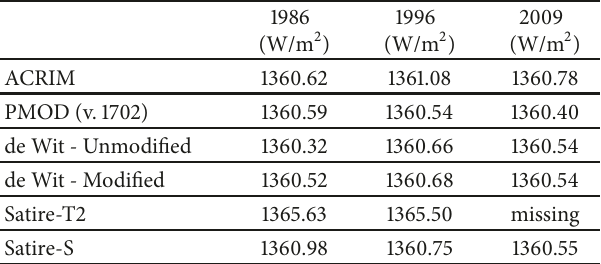
Table1:MeanvaluesoftheTSIcompositesolarcycleactivityduring the year of their minima. The error bar of the annual mean values is less than 𝜎 =0.01 W/m 2